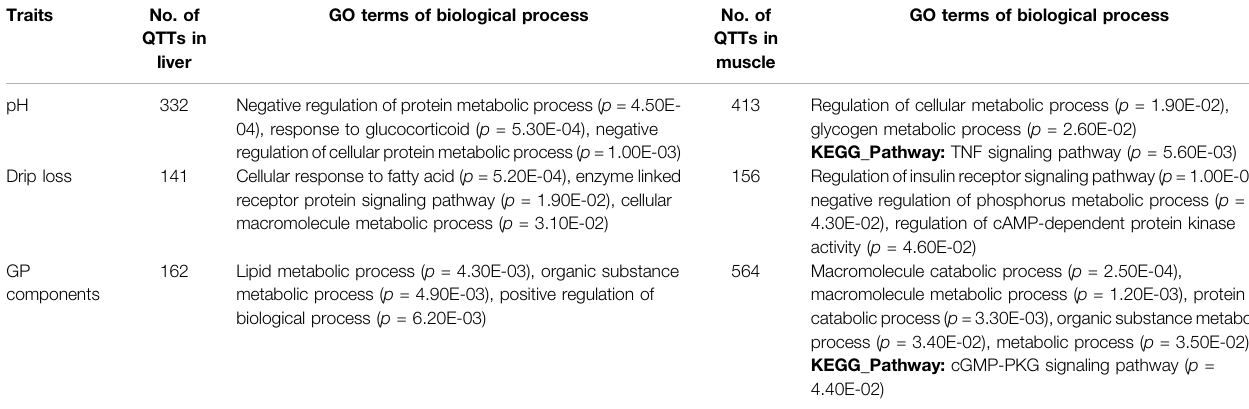
TABLE 2 | QTTs for pH, drip loss, and GP components identi fi ed in liver and muscle tissues. Traits No. of QTTs in